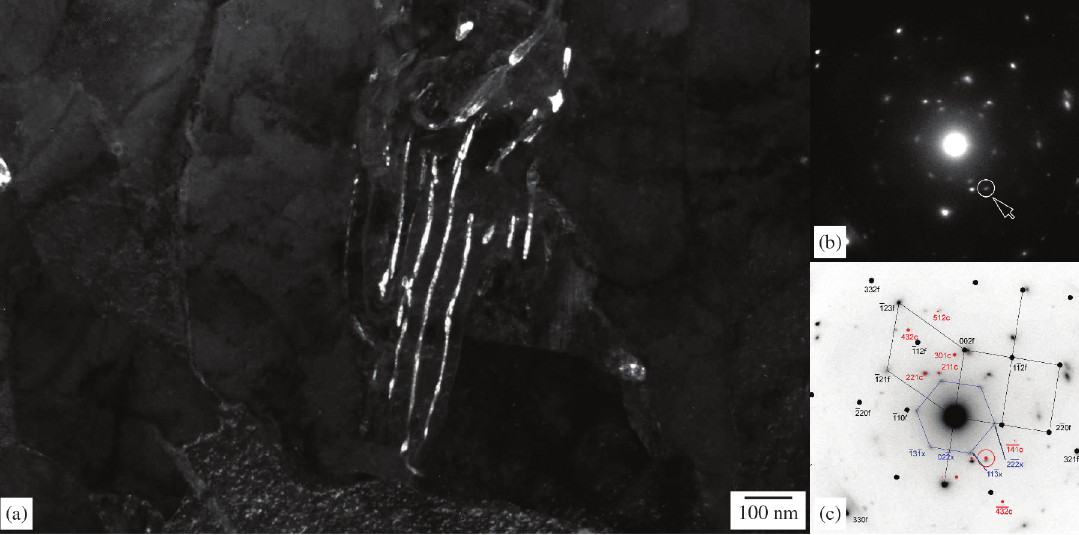
– 02]c in a region with ferrite zone axis